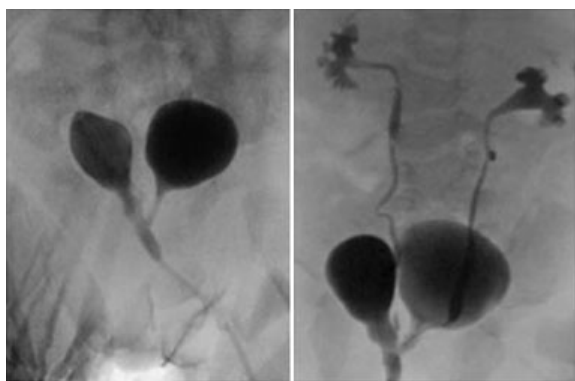
Fig. 2 Retrograde pyelogram showing a side-by-side duplication of thebladder withasingle ureter enteringeachbladder in apatient with covered cloacal